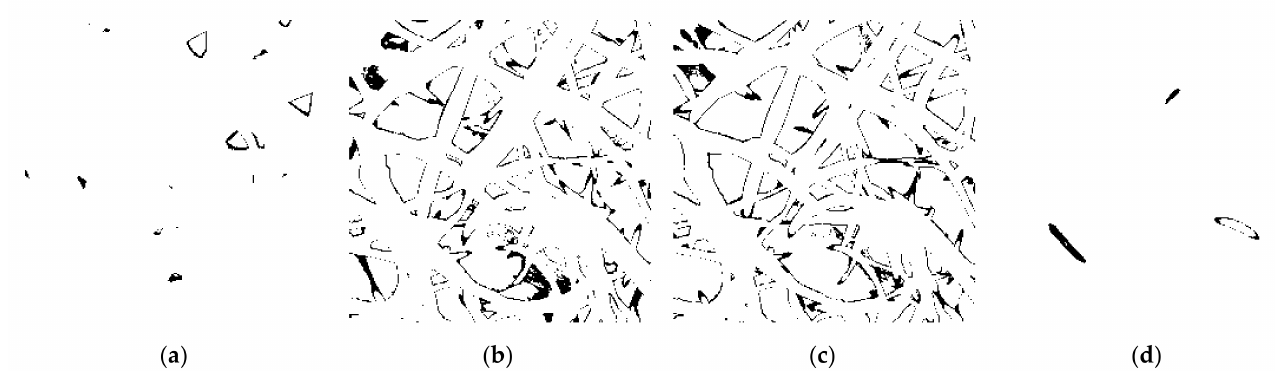
Figure 3. Gray-scale distribution (excerpt) of Figure 2a: ( a ) channels 32–39; ( b ) channels 104–111; ( c ) channels 112–119; ( d ) channels 208–215. Comparing with Figure 2a, one can conclude that ( a ) is connected with deepest features that are darkest, while ( d ) is correlated with the top features that are brightest; hence, the gray scale reflects the 3D structure of the image.